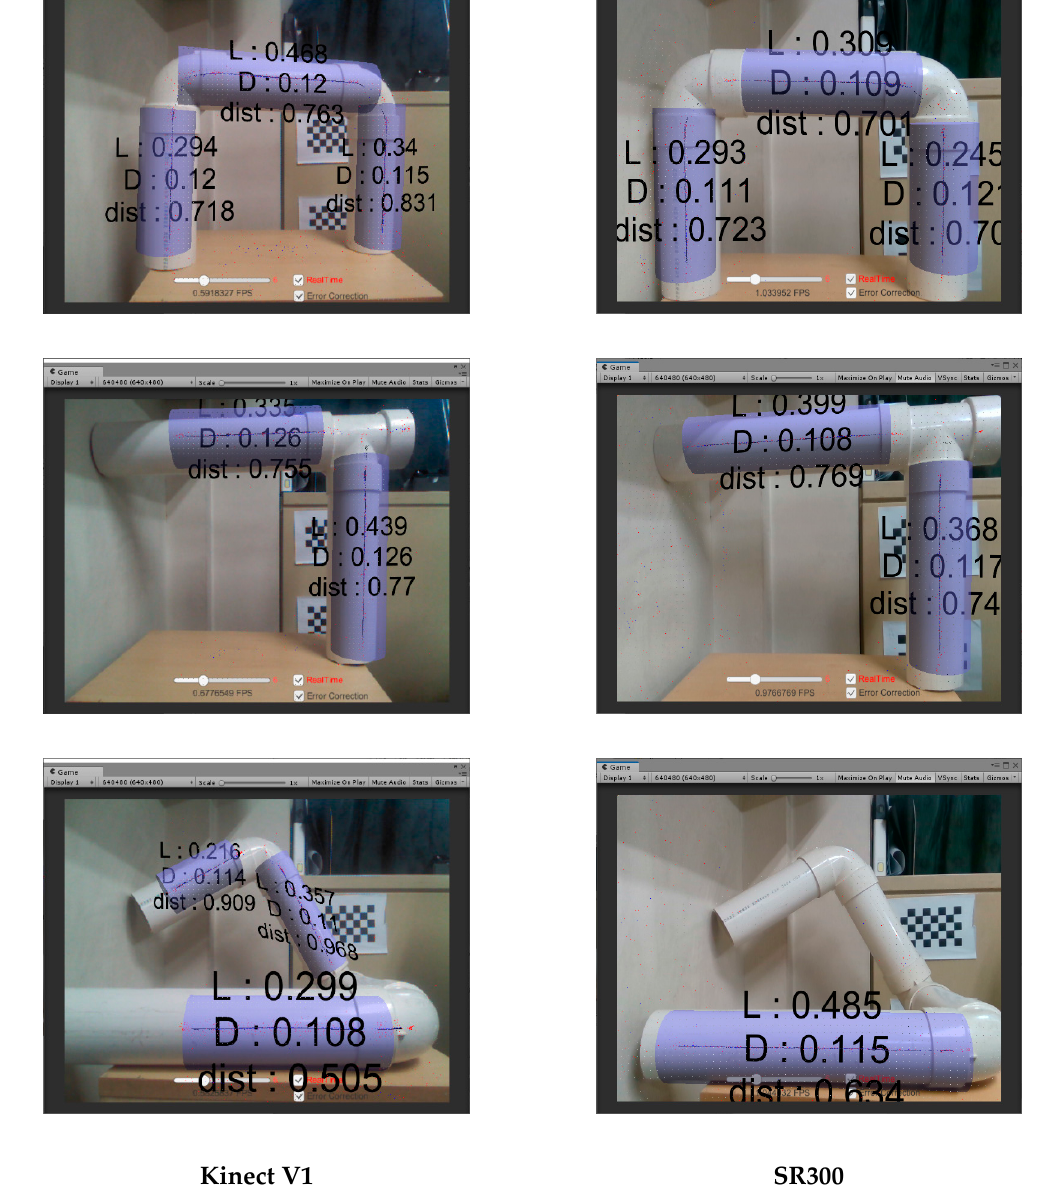
Figure 23. Real-time matching results for six cores and six frames; 𝛜 = 50 error correction mode. (m)